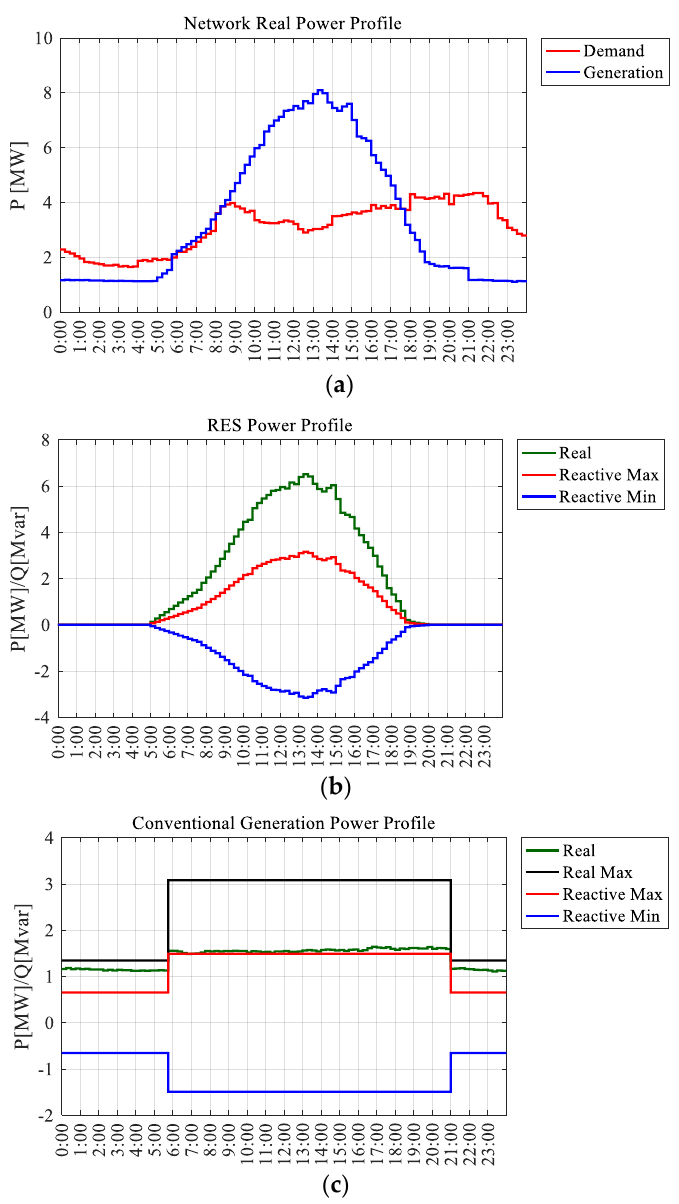
Figure 10. Adopted generation/demand profiles for the studied distribution feeder: ( a ) overall generation and demand real power profile; ( b ) RES power profile; ( c ) conventional generation power profile.